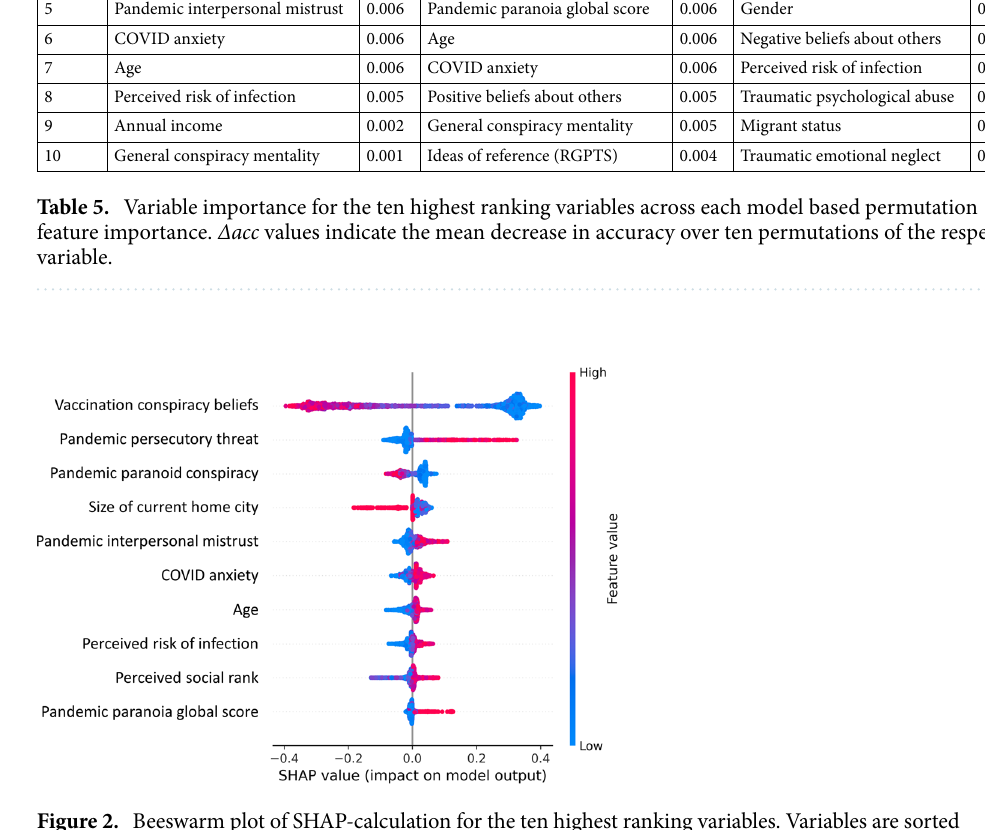
Figure 2. Beeswarm plot of SHAP-calculation for the ten highest ranking variables. Variables are sorted by their mean absolute SHAP value in descending order with most important variables at the top. Each dot corresponds to one person in the study. The beeswarm plot shows how the different variable expressions of each person affect the prediction of the ML model towards vaccine willingness. Positive SHAP values indicate a change in the expected model prediction towards vaccine willingness. The plot is based on the ML model with all variables included and leave-one-site-out-cross